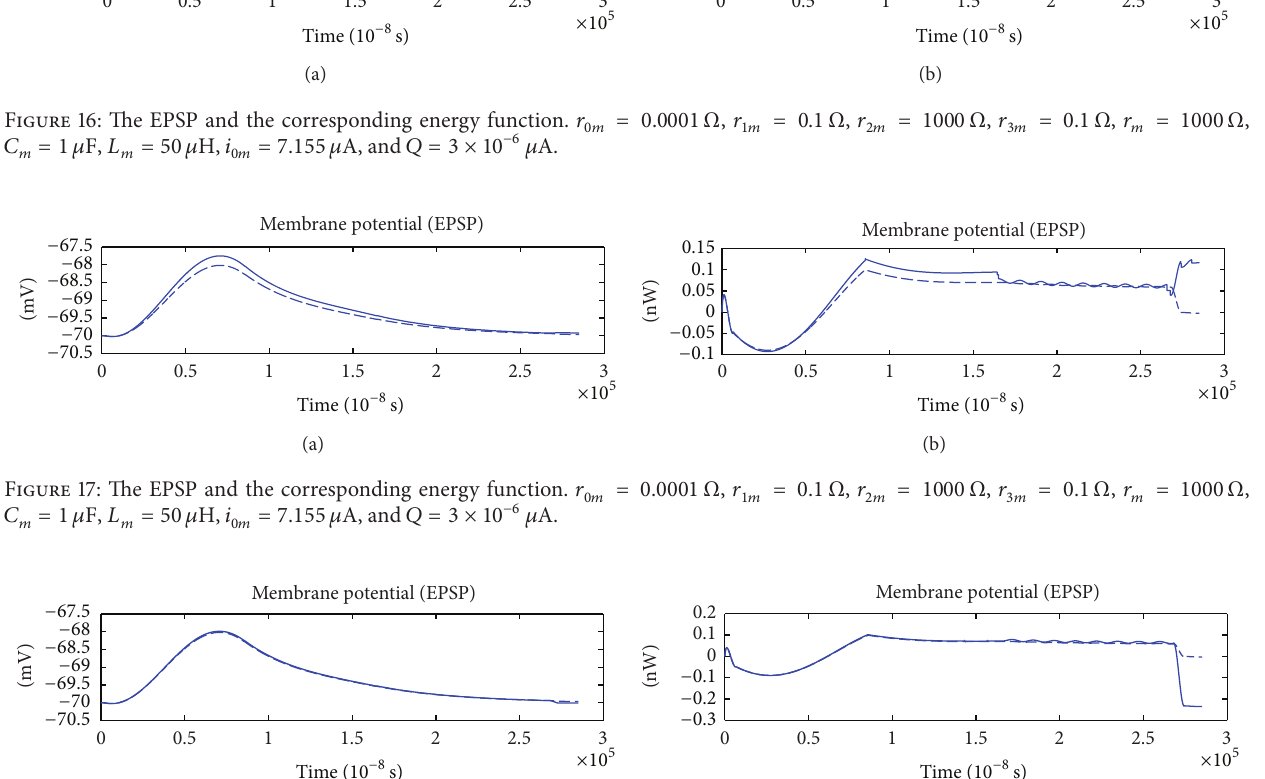
curve increased first and then decreases with a maximum of − 68 mV and a minimum of − 70 mV. The energy function